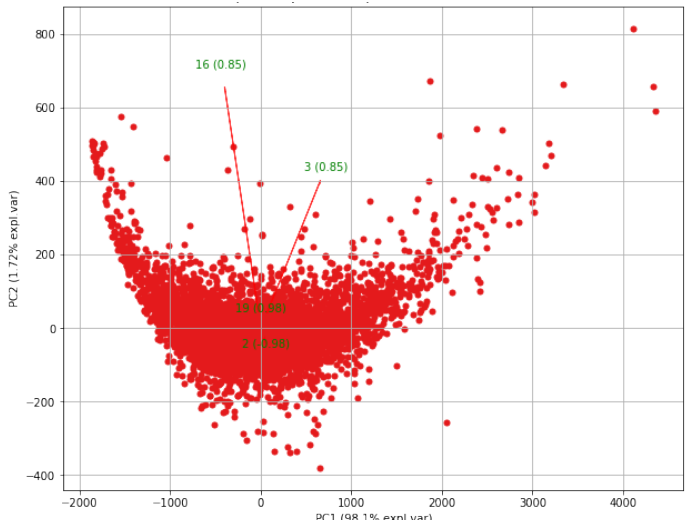
Figure 5. Visualization of the two components that explain 99% of variance as identified by method Principal Component